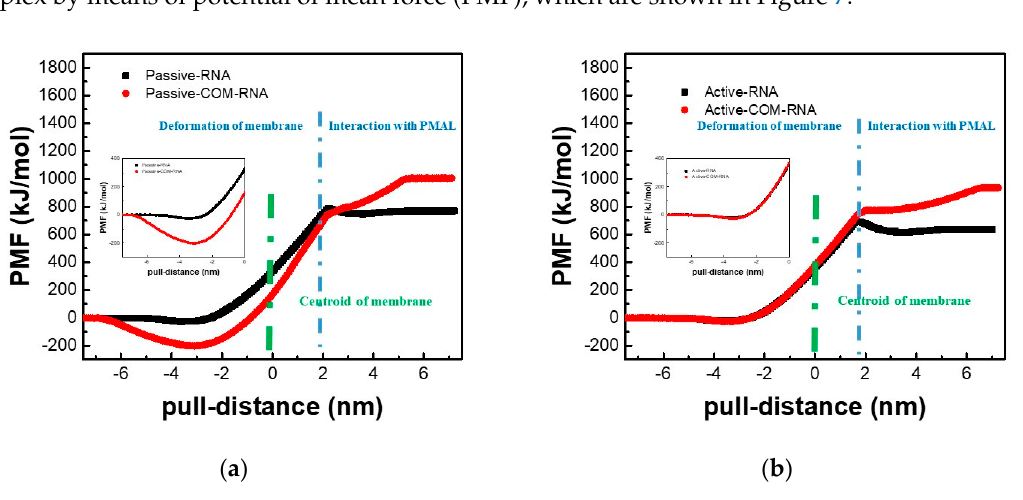
Figure 7. PMFs of the naked siRNA and the siRNA-PMAL complex during transmembrane. ( a ) Passive transport. ( b ) Active transport.